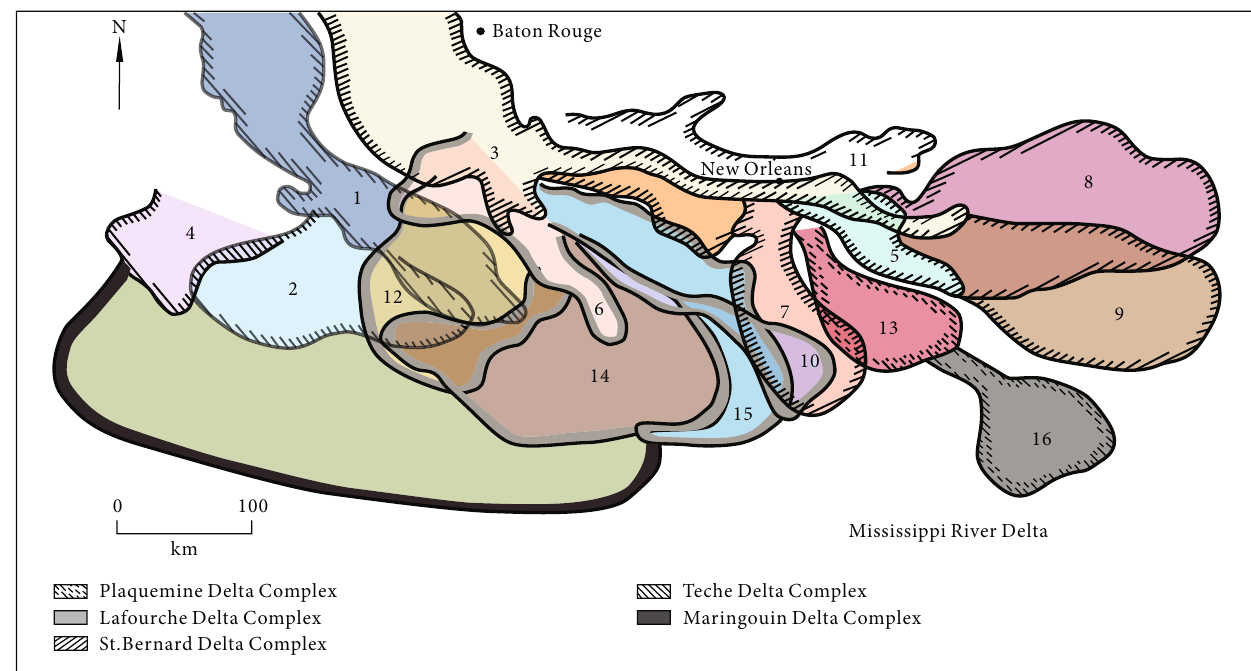
Figure 4: Regional distribution of modern Mississippi River deltas and lobes (Frazier 1967; Fisher & McGowen, 1969; [22]).